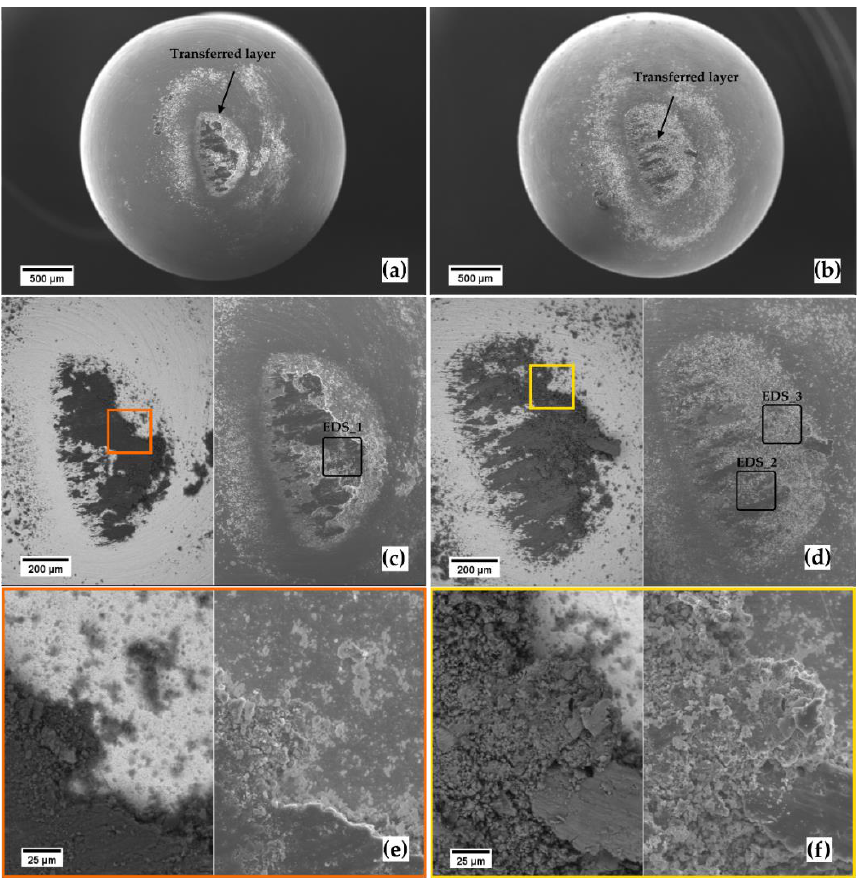
Figure 3. SEM micrographs. Worn ball-end surface at increasing magnification for the Ti20–AlSi ( a , c , e ), and for the Ti80–AlSi ( b , d , f ). ( a , b ) and the left micrographs of ( c – f ) are from the backscattered electrons detector; the secondary electron detector acquired the remaining